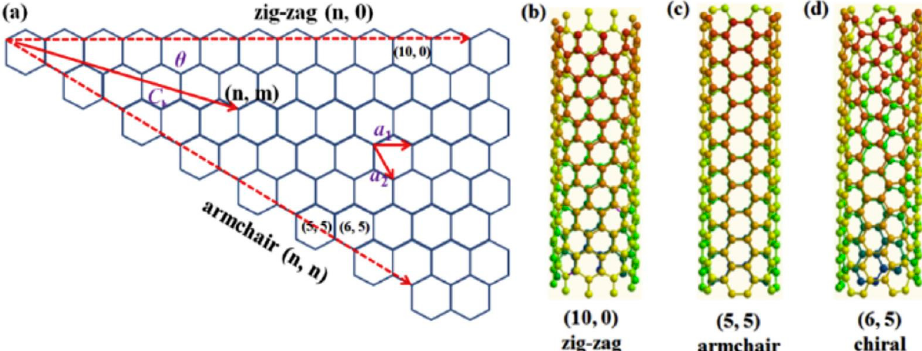
Figure 4. ( a ) Unrolled single layer graphene sheet showing the geometry of single-wall